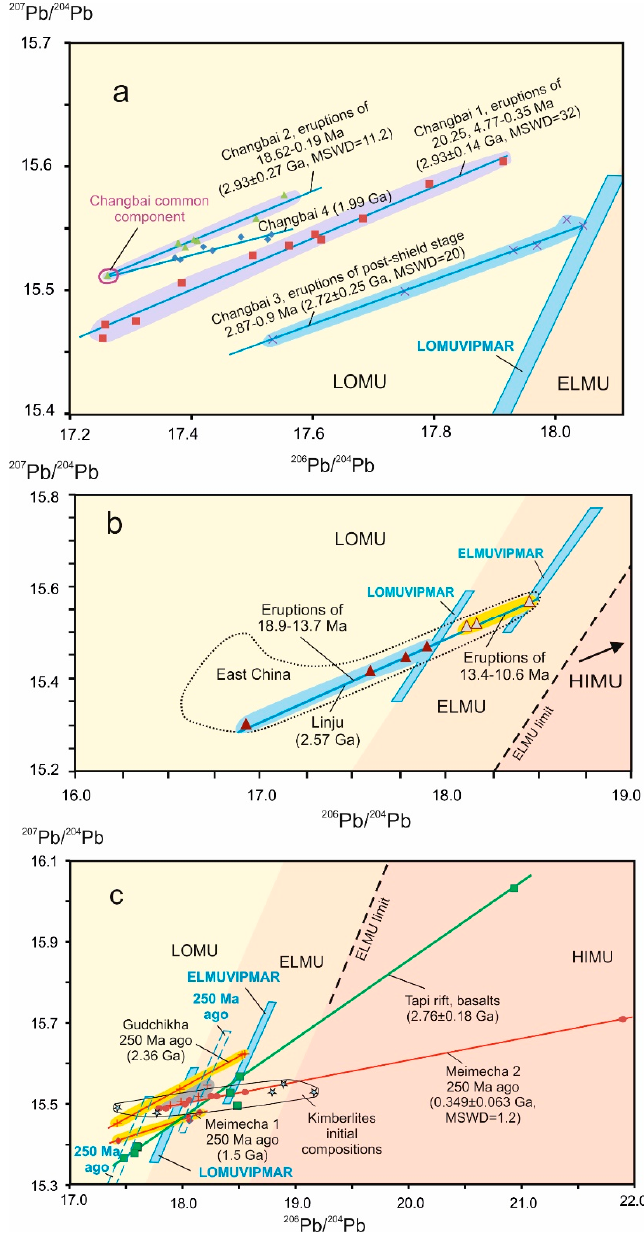
Figure 8. Diagrams of 207 Pb/ 204 Pb versus 206 Pb/ 204 Pb for basic rocks from volcanic fields of Northeast China (( a )—Changbai, ( b )—Linju) and paleocontinents (( c )—Indian, Tapi Rift and Siberian, picrites and picrobasalts of the Gudchikha Formation, meimechite groups Meymecha 1 and 2). In diagrams a and b, the LOMUVIPMAR and ELMUVIPMAR compositions, as well as LOMU – ELMU and ELMU limit discriminate lines are shown as in Figure 5. In diagram a, the Changbai common component is defined at the least radiogenic Pb isotope composition ( 206 Pb/ 204 Pb = 17.26, 207 Pb/ 204 Pb = 15.51). In diagram c, initial Pb isotope compositions of kimberlites are plotted for comparison. The secondary isochrones were calculated using the Isoplot program [87]. Data are from [41,48,52,54,57,96,97,98].